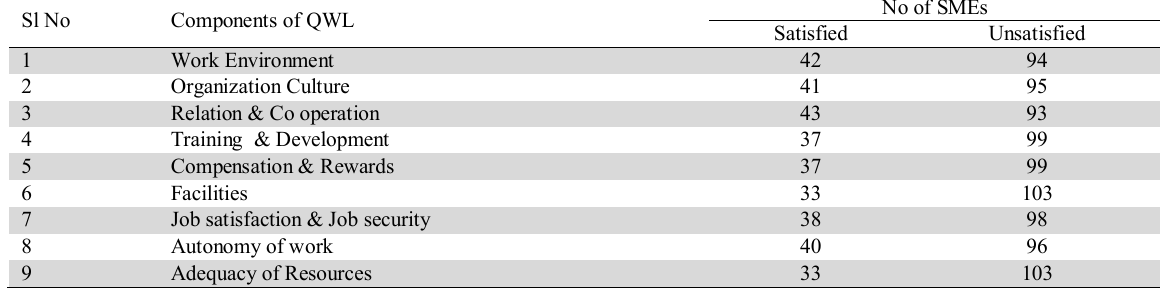
Status of QWL Components under Transformational leadership style in